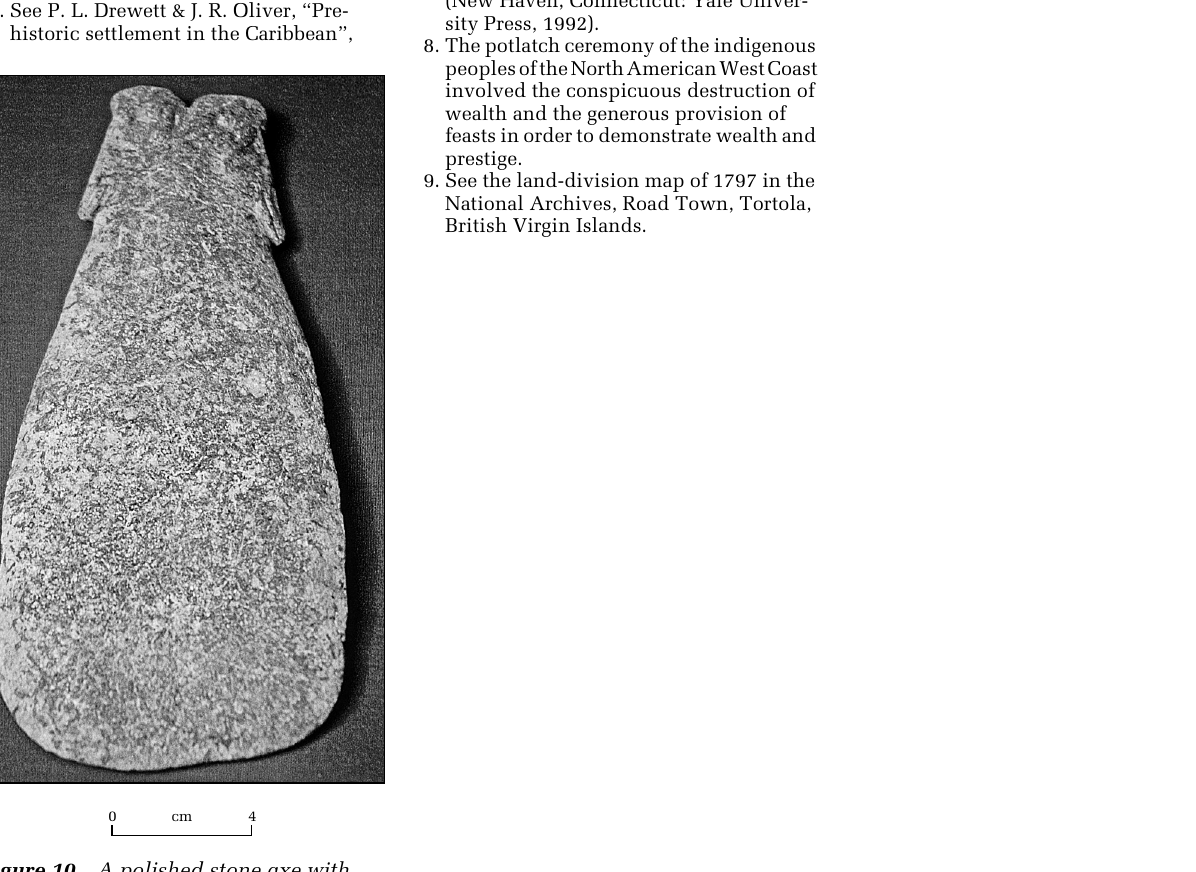
Figure 10 A polished stone axe with carved pelican heads, made out of local volcanic tuff, c. AD 1200–1400.